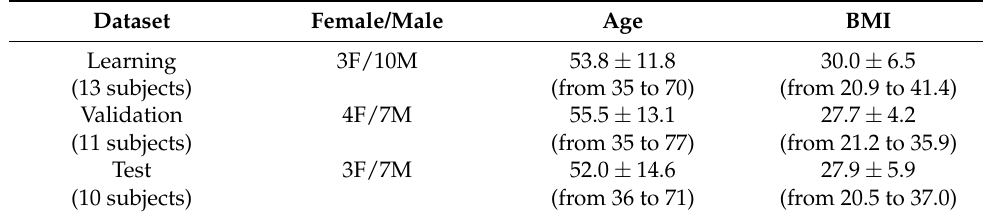
Table 2. Dataset compositions in terms of sex, age, and body mass index